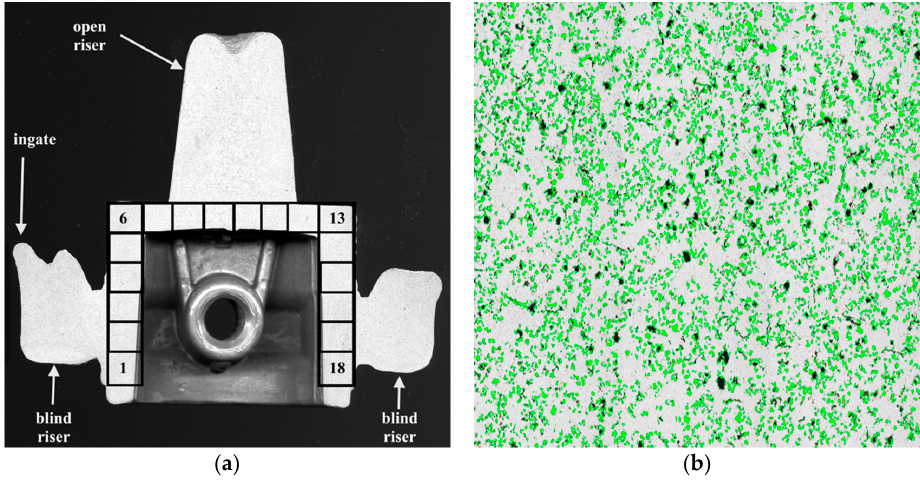
Figure 3. Particle distribution within the cast: ( a ) cross section of composite piston with marked 18 measurement areas marked; ( b ) sample of single analyse image, surface area 4.58 mm 2 .